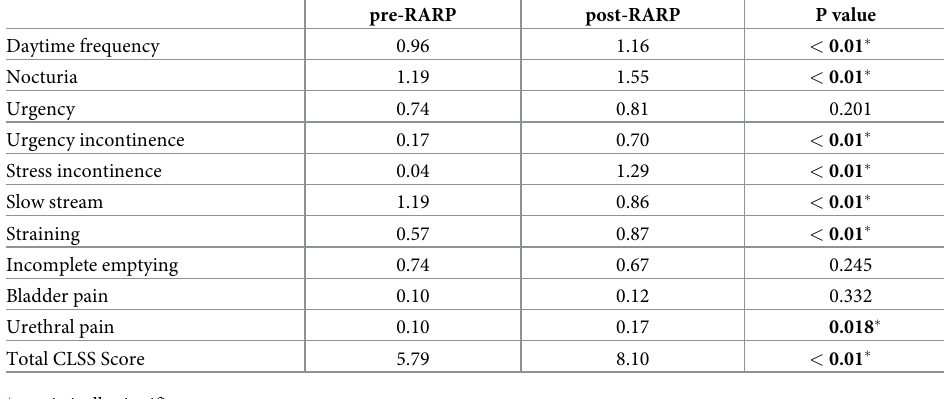
Table 2. Comparison of pre- and post- operative results of CLSS questionnaire.